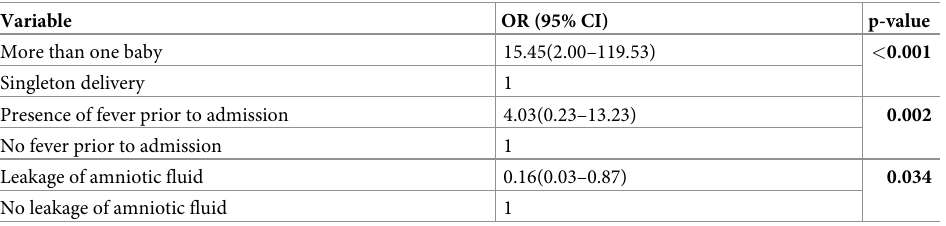
Table 5. Multivariate association between preterm labour and independent variables for mothers delivering between 24 to 28 weeks of gestation at Kawempe National Referral Hospital,